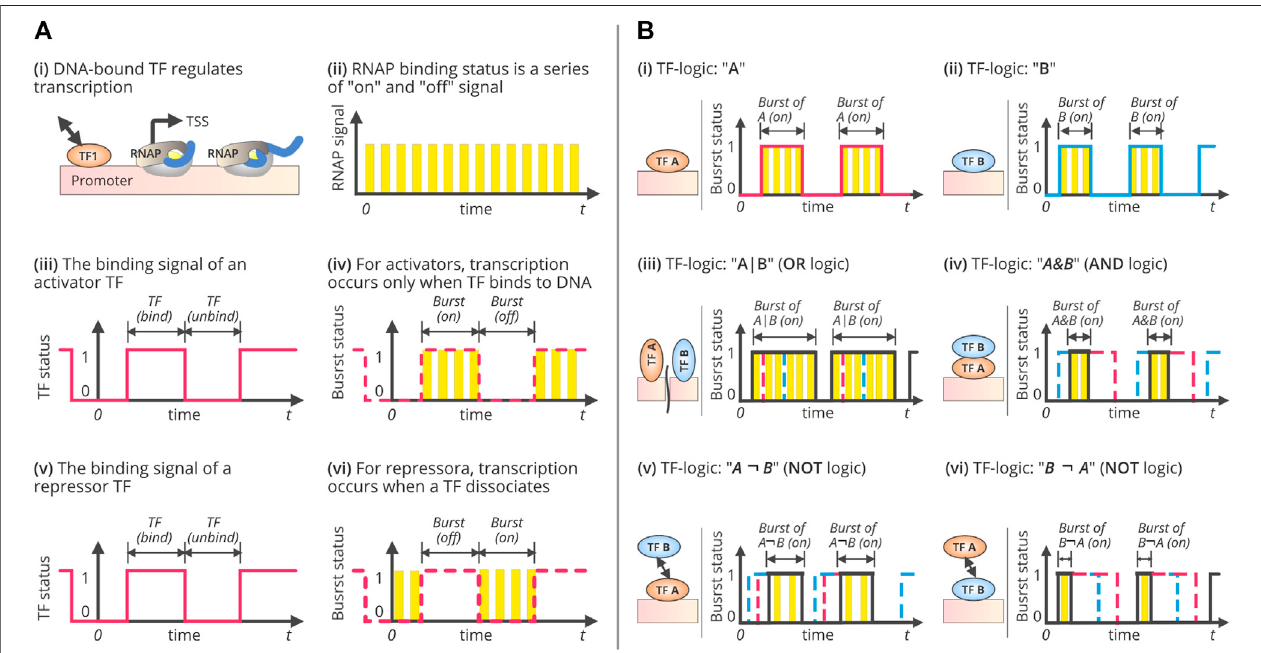
FIGURE 2 | TF-driven gene regulation, transcriptional bursting, and combinatorial regulatory TF-logics. (A) Single-TF regulation and transcriptional bursting. It illustrates the process of gene transcription under single-TF regulation. During transcription, RNAP binding (i) can be viewed as a series of on/off signals, as shown in (ii). Each “ on ” status is corresponding to a transcript initiation. Therefore, the frequency of the “ on ” events are equivalent to the rate of transcript initiation, as well as the mRNA synthesis rate if every synthesized pre-RNA is converted into a mature mRNA. Similarly, the TF binding status can also be viewed as a digital signal with a seriesof “ bind ” and “ unbind ” events.TheTF “ bind ” statelastsfromthemomentofTFbindingtothetime ofTF-DNAdissociation. ThedurationofTFbindingdependson the relative af fi nity of its competitors, such as other DNA binding molecules. The “ unbind ” state, however, refers to the status that the promoter is not bound by the TF. The duration of the “ unbind ” state is the time that TF spends searching for the binding site after TF-DNA dissociation. Since the transcription can only be initiated during TFbinding(incasethattheTFisanactivator),orduringtheprocessofTFdisassociation(incasethatTFisarepressor),thusmakingthetranscriptionoccursinbursts.(iii) and (iv) show the binding signal of an activator TF and the transcriptional bursts, while (v) and (vi) show the binding signal of a repressor TF and the bursts. (B) Three fundamental combinatorial logics of gene regulation and their bursting patterns. Three fundamental logics of combinatorial gene regulation and the patterns of transcriptional bursts. It illustrates the process of gene transcription under two-TFs regulation while forming three basic combinatorial logics, OR, AND, and NOT. In systems biology, the regulatory interactions between TFs are typically represented as logic, such as OR (denoted by “ | ” ), AND ( “ & ” ), and NOT ( “ ¬ ” ). This fi gure shows several logics and the corresponding bursting patterns, (i) while the TF, “ A ” acts as an activator; (ii) while the TF, “ B ” acts as an activator; (iii) while the TF, “ A ” and “ B ” cooperate with OR logics by forming, A|B logic gates; (iv) while the TF, “ A ” and “ B ” cooperate with AND logics by forming, A&B logic gates; (v) while the TF, “ A ” and “ B ” interactswithNOTlogicsbyforming,A¬Blogicgates,impliesthat “ A ” shouldbepresenttoactivatethetranscriptionbut “ B ” shouldnotbepresent;and,(vi)whiletheTF, “ B ” and “ A ” interacts with NOT logics by forming, B¬A logic gates, implies that “ B ” should be present to activate the transcription but “ A ” should not be present. Speci fi cally,twoTFscanformelevenlogics,including, (1)noTFneeded( “ None ” );(2)onesingleactivator “ A ” ;(3)onesingleactivator “ B ” ;(4)onesinglerepressor “ A* ” ;(5) one single repressor “ B* ” ; (6) “ A ” or “ B ” can independently activate gene transcription, denoted as A|B; (7) “ A ” and “ B ” need work cooperatively to activate the gene, i.e. A&B; (8) “ A ” is an activator while “ B* ” is a repressor, i.e. A¬B*; (9). “ B ” is an activator and “ A* ” is a repressor, i.e., B¬A*; (10) “ A ” or “ B ” can independently repress gene transcription, i.e., A*|B*, and (11) “ A ” and “ B ” need work cooperatively to repress gene transcription, i.e.